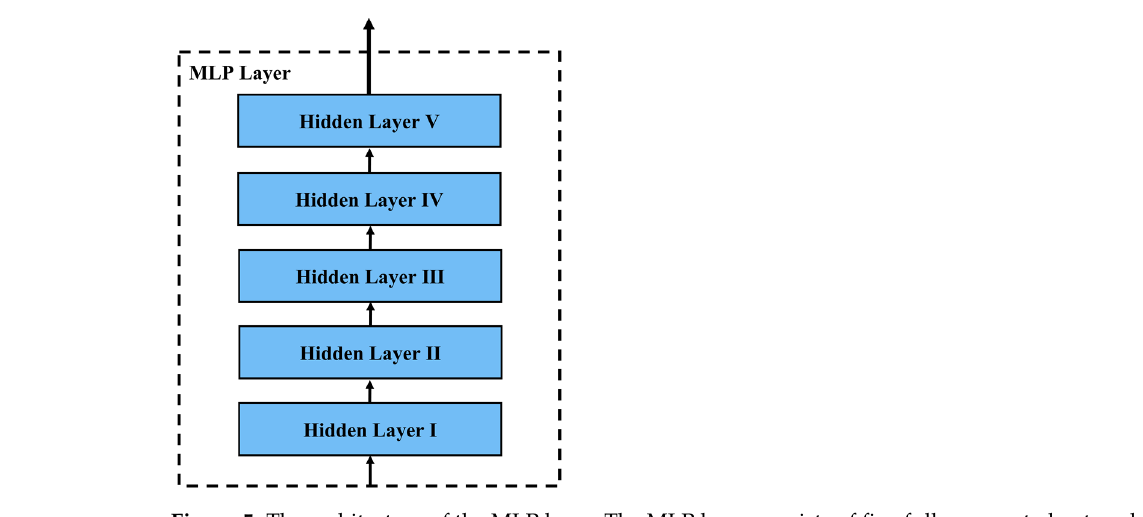
Figure 5. The architecture of the MLP layer. The MLP layer consists of five fully connected networks. Hidden layer V uses Softmax as the activation function and finally outputs the result.